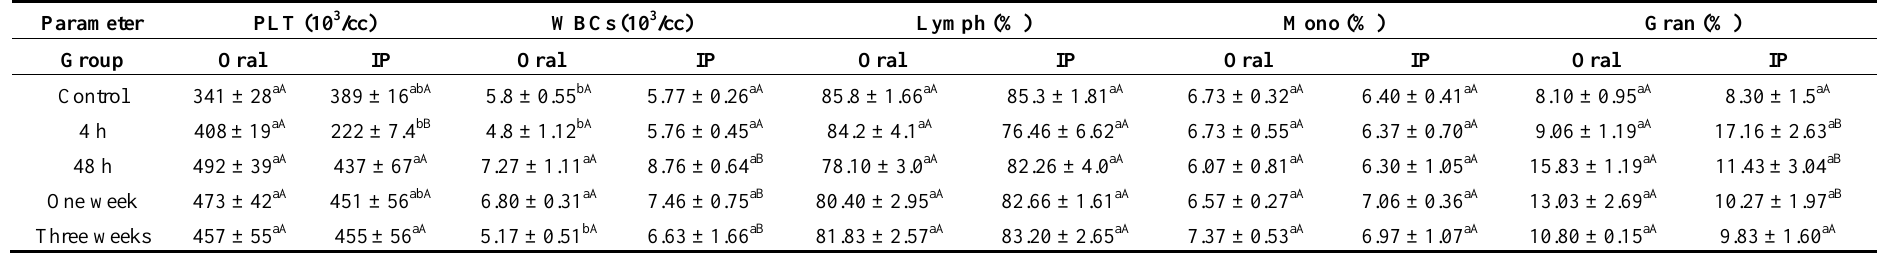
Table 1. The effect of oral administration and intraperitoneally (i.p.) injection of ENPs on white blood cells (WBCs) and deferential counts in rats. PLT, platelet. Parameter